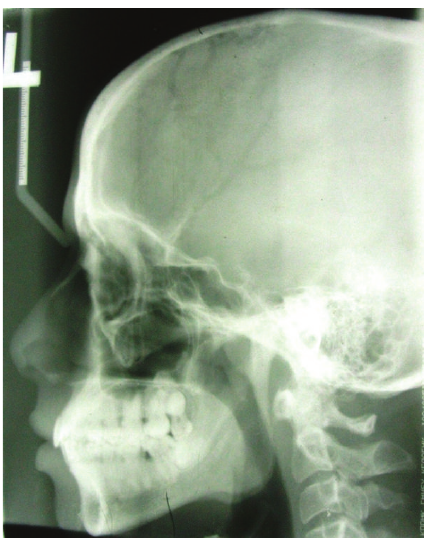
Figure 2: Plain radiograph revealing no bony involvement, but phleboliths can be noticed.